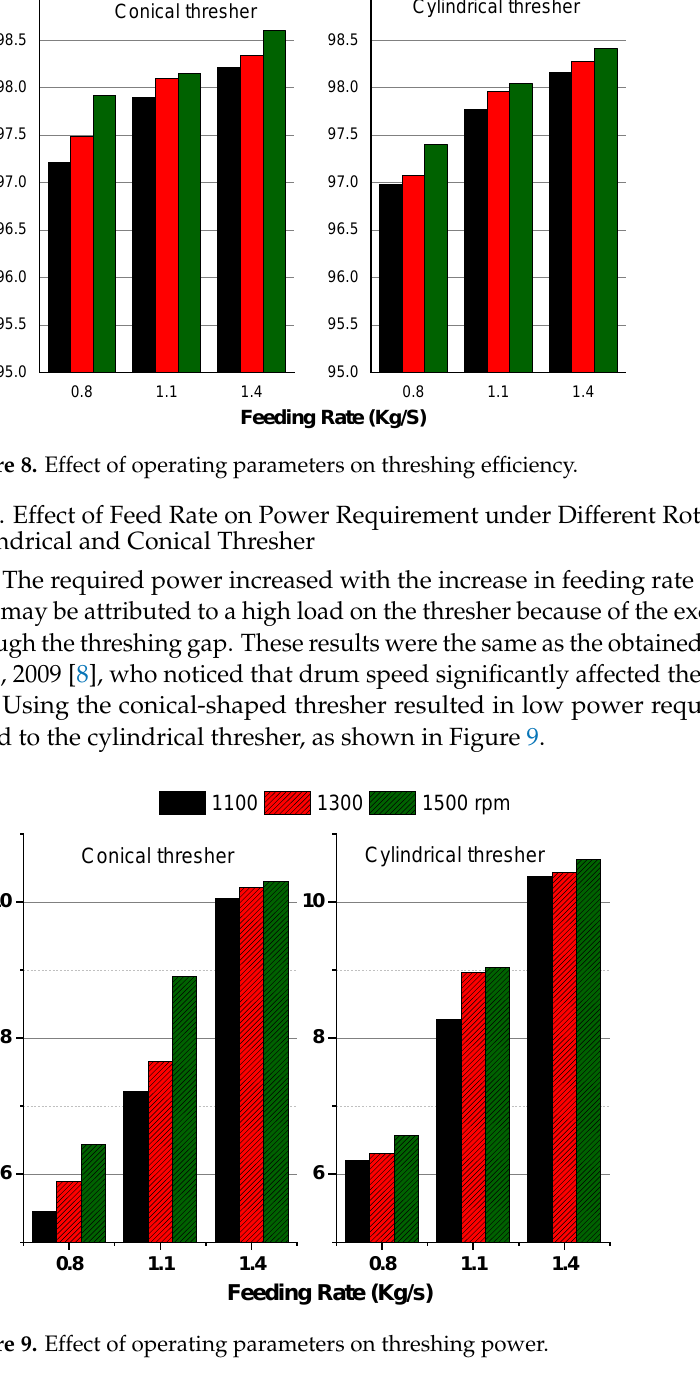
Figure 9. Effect of operating parameters on threshing power.